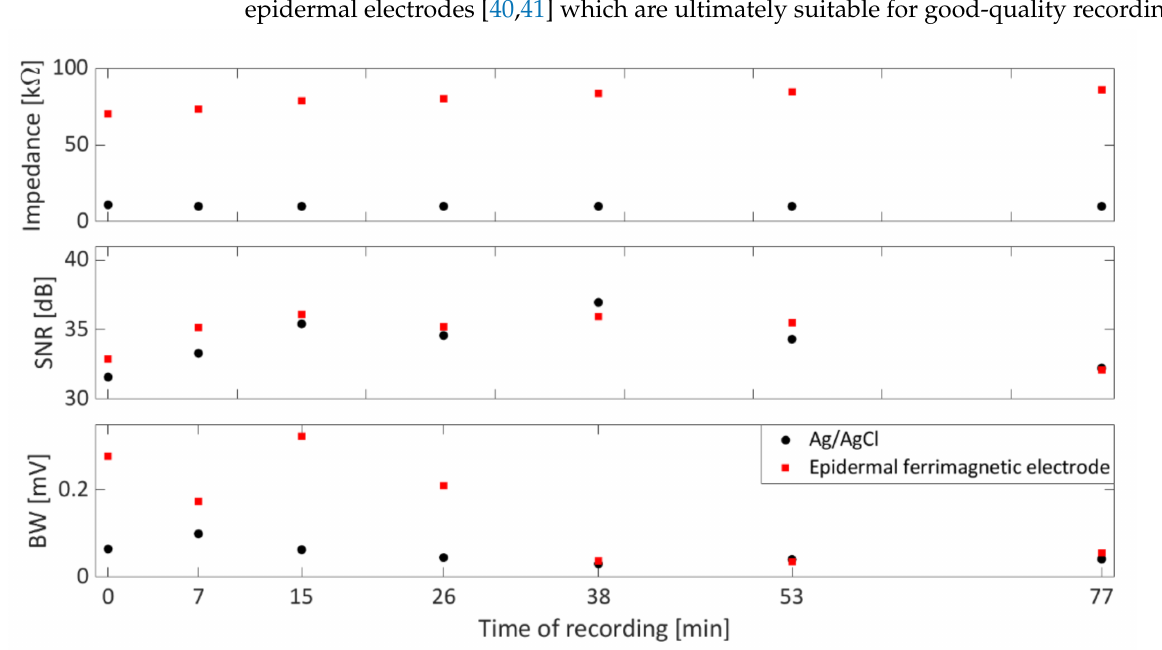
Figure 4. Trends for the skin–electrode contact impedance ( top ), SNR ( middle ), and BW ( bottom ) evaluated at the different recording times on the ECG signals recorded by Ag/AgCl electrodes ( • ) and the ferrimagnetic-conductive epidermal electrodes ( (cid:4) ). The 0 min time of recording refers to the first ECG acquisition, while the last time of recording (77 min) refers to the last recording session, which was performed on the same subject, after 77